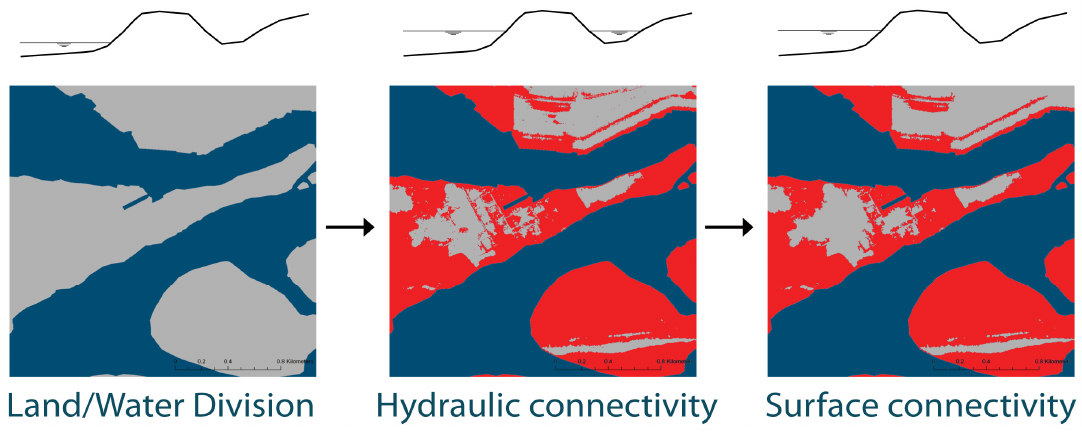
Figure 3. Bathtub principle (red indicates simulated inundated